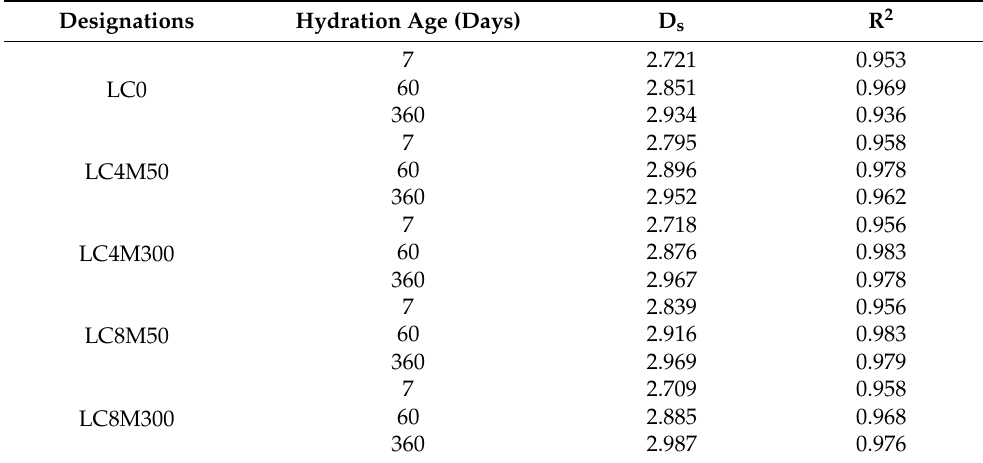
Table 5. Pore surface fractal dimension of LHP concrete added with